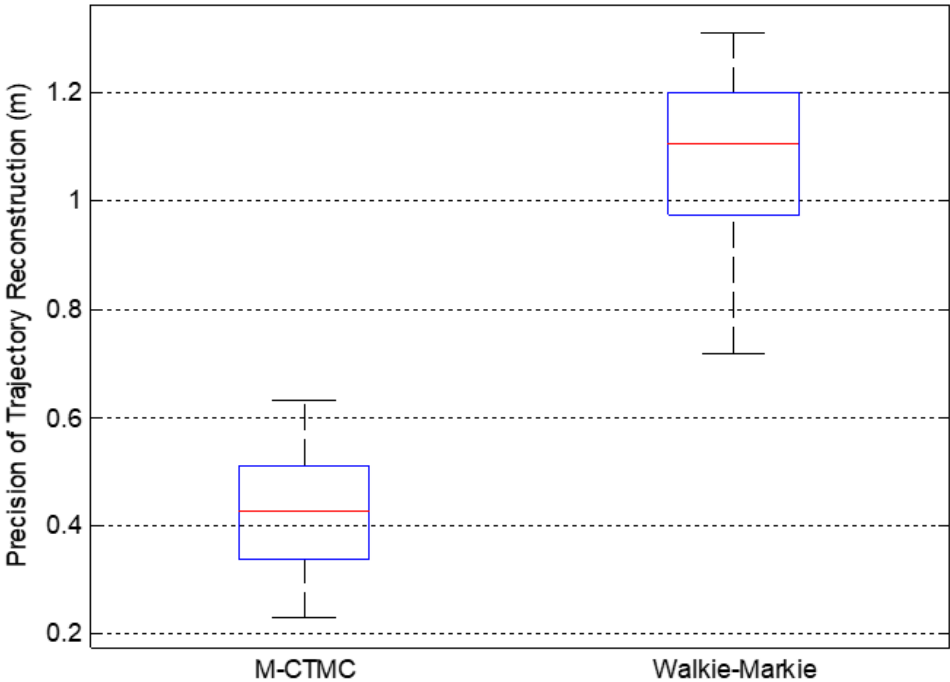
Figure 12. Precision Comparison of M-CTMC and